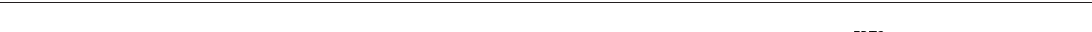
Fig. 1 Blimp1 marks unipotent embryonic luminal stem cells. a Lineage tracing strategy adopted in b - d . Prdm1Cre ERT2 mice are crossed to R26R mTmG reporter mice. Pregnant females were injected intraperitoneally with tamoxifen (TAM, 0.5 mg/25 g body weight) at embryonic day (E) E12.5, E14.5 or E17.5. Double transgenic littermates Prdm1Cre ERT2/ + ; R26R mTmG/ + were analysed 24 h later. b Cryosections (100 μ m thick) from E13.5, E15.5 and E18.5